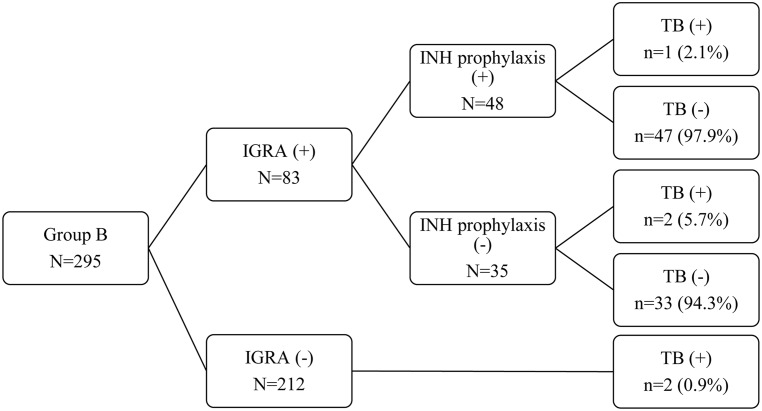
Isoniazid prophylaxis and tuberculosis.INH prophylaxis did not significantly reduce the incidence of TB (P = 0.548). Among 5 TB patients in group B, one patient had INH prophylaxis. IGRA negative included indeterminate results. IGRA, interferon-γ release assays; INH, isoniazid; TB, tuberculosis.